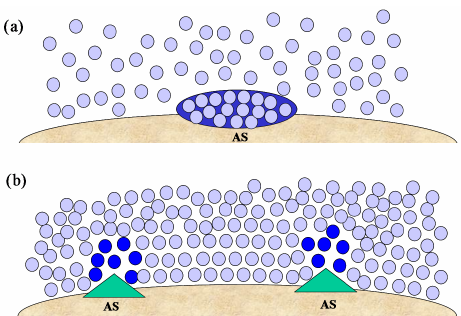
Figure 3. Different representations of immersion freezing. (a) an ice germ (dark blue) forming on an active site (AS) by random col- lision of water molecules (light blue). (b) low-density regions (dark blue) forming in the vicinity of active sites within a dense liquid phase (light